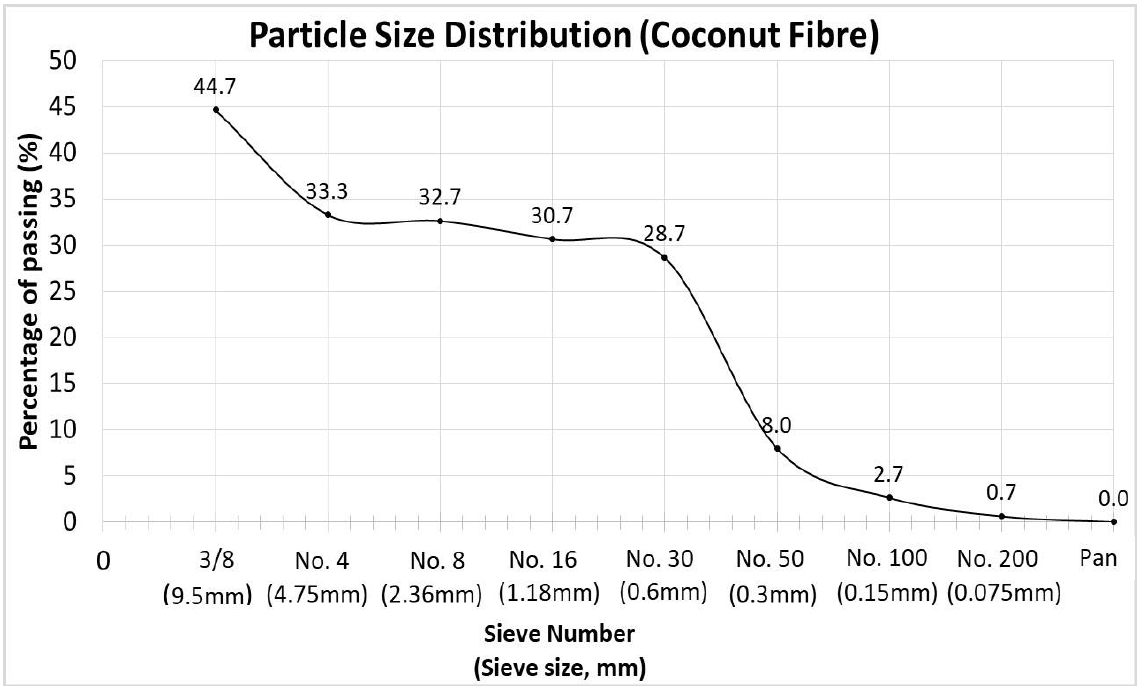
Figure 5. Particle Size Distribution for Coconut Fibre .